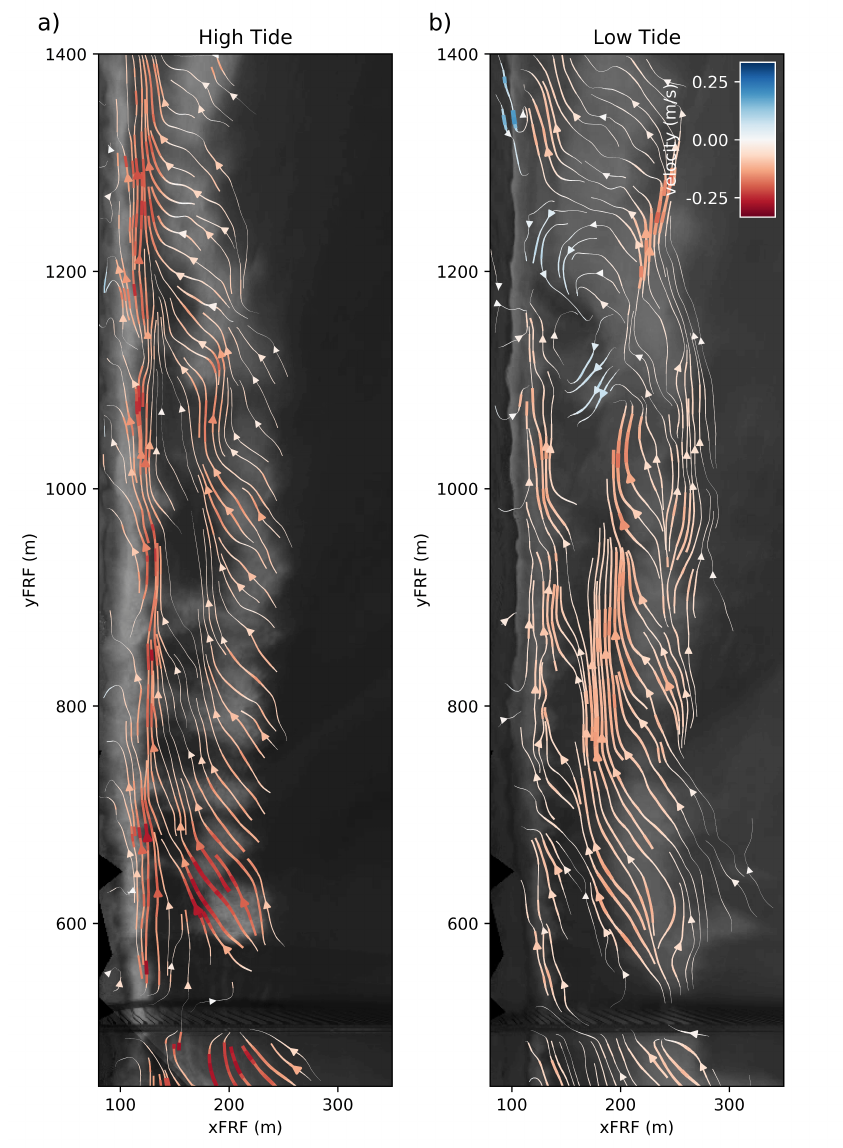
Figure 9. Mean current patterns from 17 min WAMs recorded on 31 October 2019 at ( a ) high tide (10:30 a.m.) and ( b ) low tide (5:00 p.m.). Streamplots are colored by the magnitude of the alongshore vector to highlight regions of flowing in opposing directions and/or